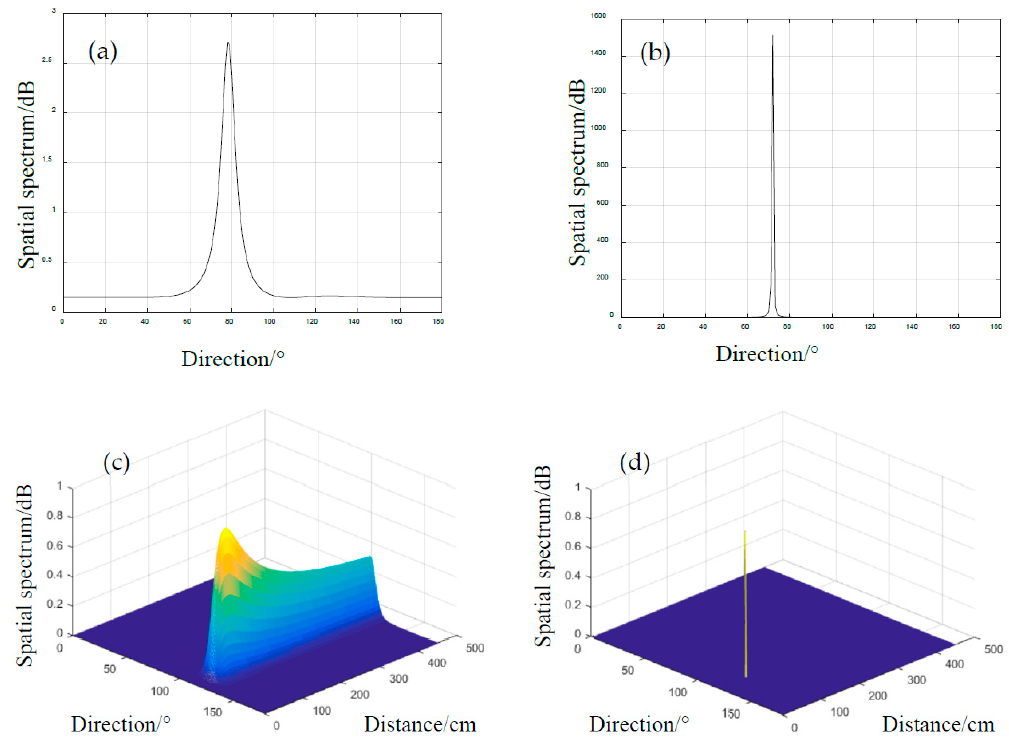
Figure 10. Spatial spectrum of case #2 at (76 mm, 121 ◦ ) estimated by ( a ) classical 1D-MUSIC algorithm, ( b ) error calibration based 1D-MUSIC algorithm, ( c ) standard 2D-MUSIC method and ( d ) the proposed method.